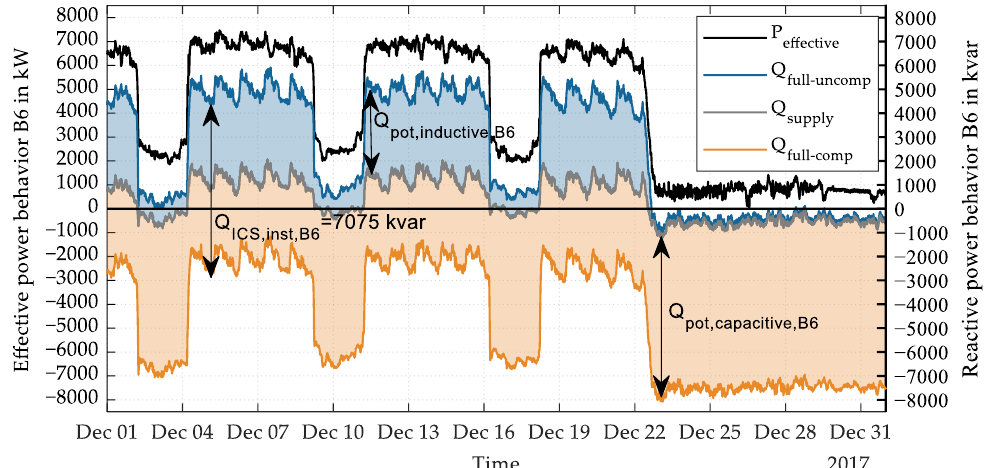
Figure 3. Effective power consumption (black line, left axis), full-uncompensated reactive power behavior (blue line, right axis), full-compensated reactive power behavior (orange line, right axis), inductive reactive power potential (blue area, right axis) and capacitive reactive power potential (orange area, right axis) with regard to the original reactive power behavior of B6 (grey line, right axis) for the month of December 2017 in minute-resolution.